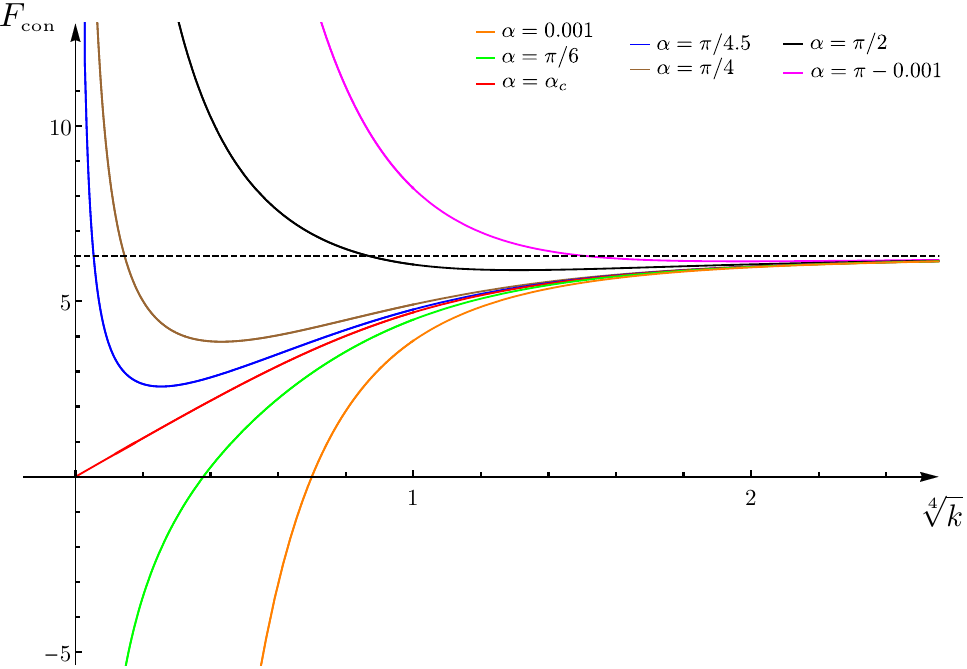
Figure 7 . The subleading term F for the extremal surfaces ^ (cid:13) con which intersect Q orthogonally p con A as a function of 4 k (see (4.13)). The horizontal dashed line corresponds to 2 (cid:25) , i.e. the value of F A for the hemisphere ^ (cid:13) dis , and it provides the asymptotic limit at large k for any value of (cid:11) . The A asymptotic behaviour for k ! 0 is given by (4.16). The curve with (cid:11) = (cid:11) c vanishes as k ! 0 p and the slope of its tangent at k = 0 is given by the coe(cid:14)cient of the O ( 4 k ) term in (4.16). We numerically observe that, for (cid:11) > (cid:11) c , the values of k corresponding to the local minima coincide with the values of k of the local minima in (cid:12)gure